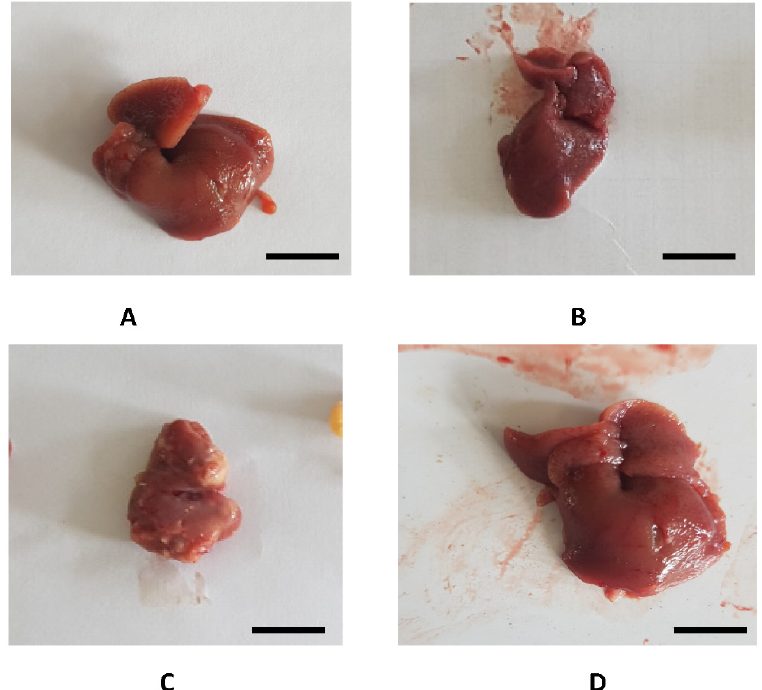
Figure 5. Photographs of liver recovered from the experimental animals. ( A ) Liver of untreated mice (NaCl); ( B ) liver section of group 2 (poly A.E); ( C ) liver section of group 3 (CCl4); ( D ) liver section of group 4 (poly A.E + CCl4). Scale bar: 10 mm.